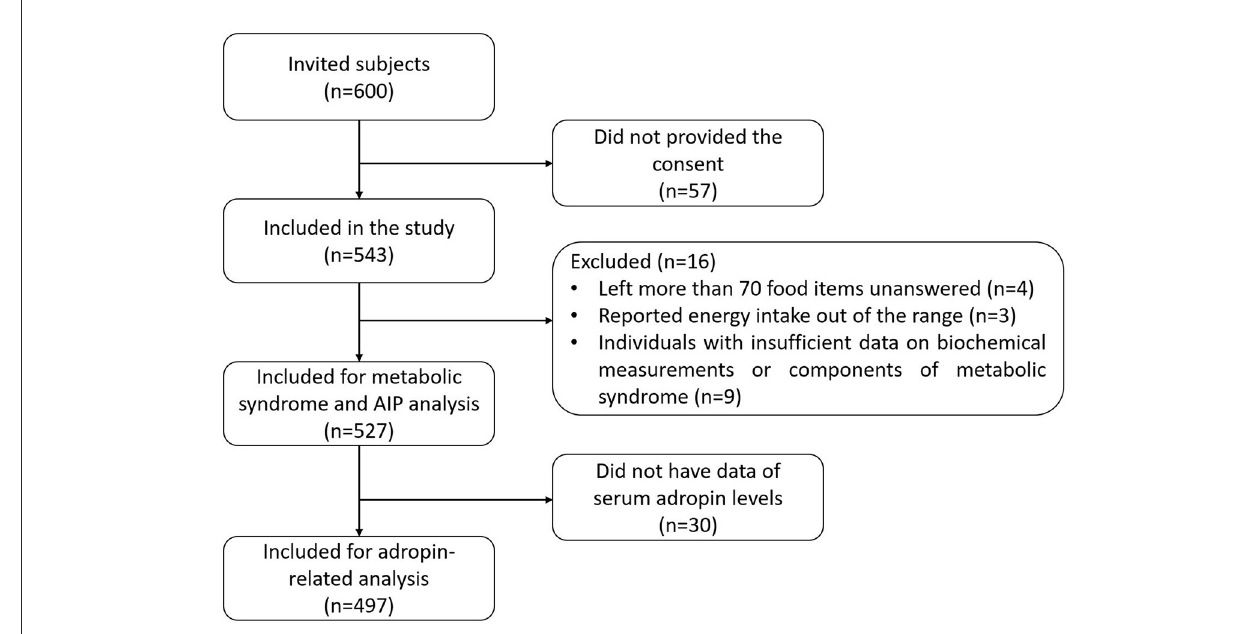
FIGURE1 The study participant flow